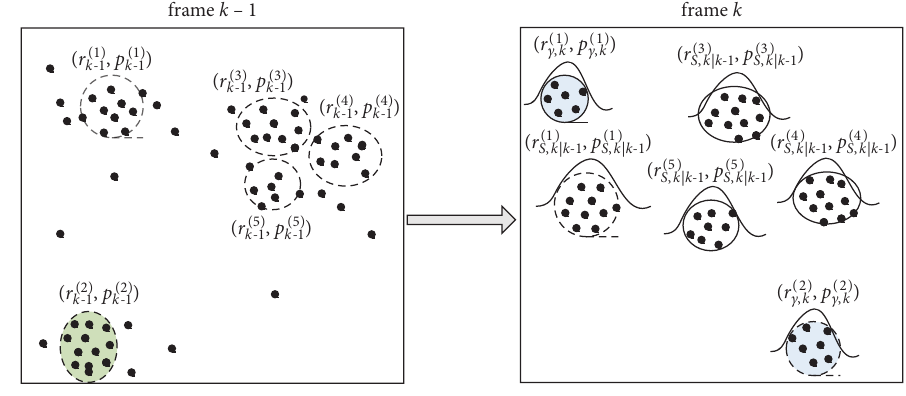
Figure 2: An illustration of Gaussian ant colony evolution corresponding